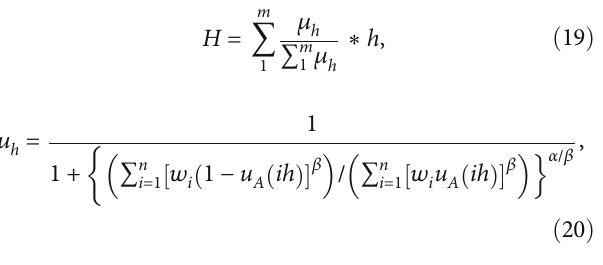
coal fl oor composite 16-17